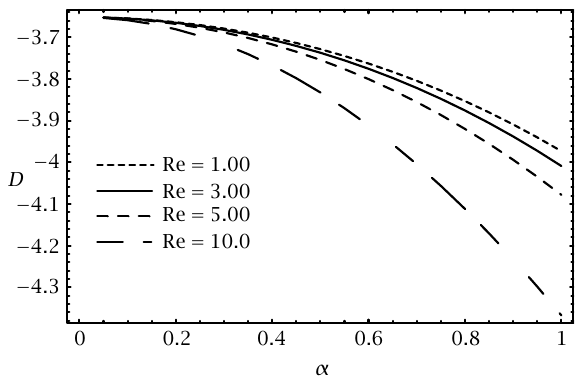
Figure 6.2 . Variation of D with wave number α and permeability parameter k at Re = 10 . 0.